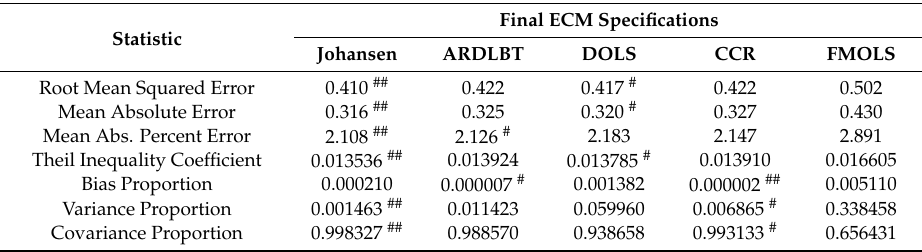
Table 10. Forecast statistics of Error Correction